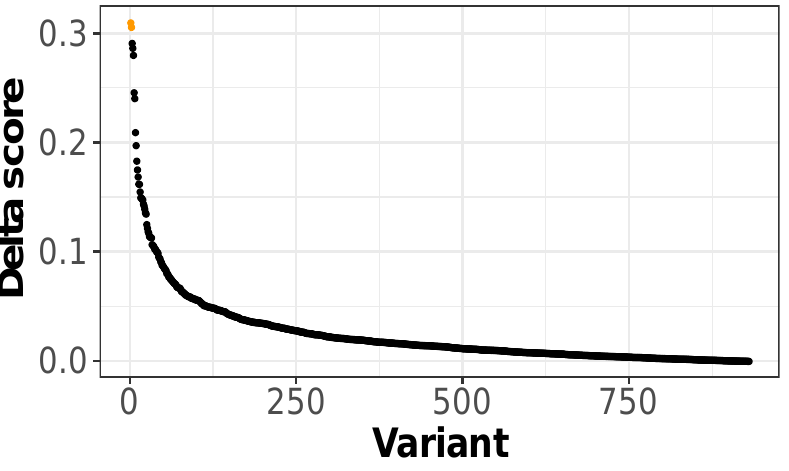
Figure 5. Delta scores of AD- and PD-related SNPS. rs1237999 and rs636317 are colored as